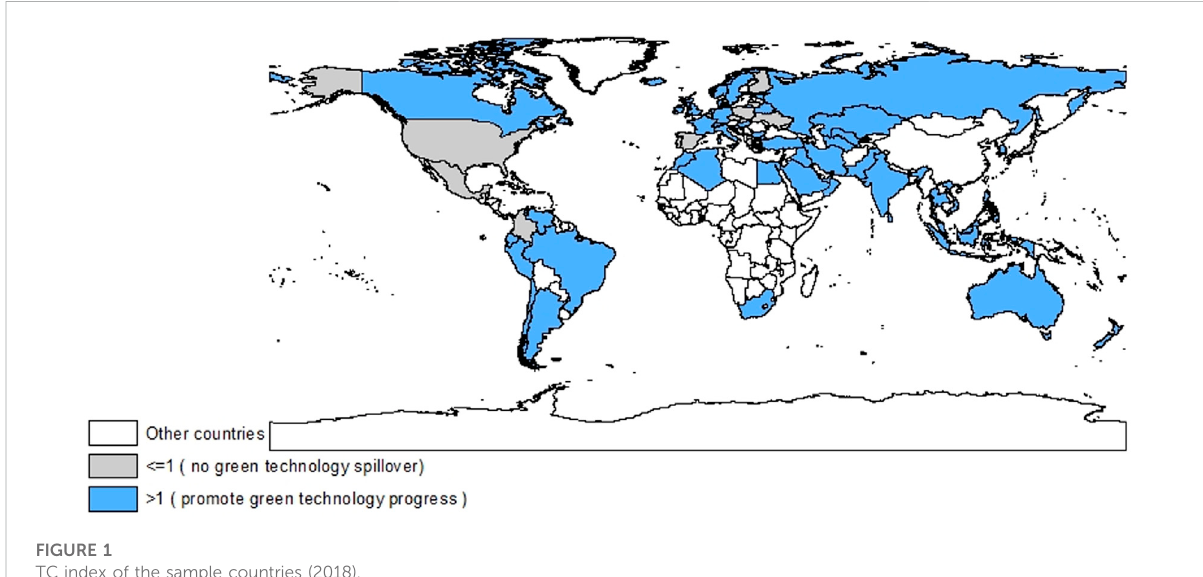
FIGURE 1 TC index of the sample countries